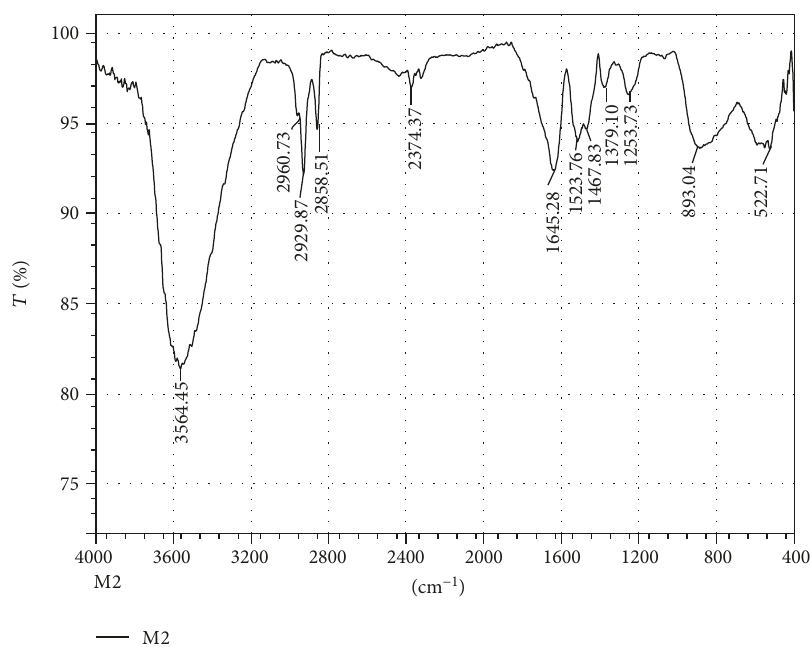
Figure 8: The FTIR spectra in the wavenumber range of 400 – 4000 cm − 1 of unmodi fi ed γ -Al